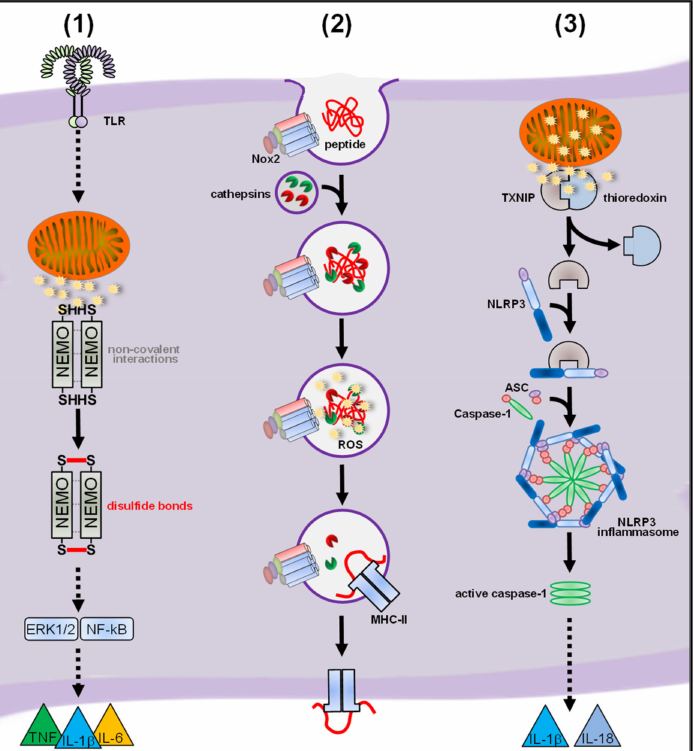
Figure 6. ( 1 ) L.m. infection induces cytosolic mtROS production by complex III of the electron trans- port chain (ETC) in a Toll-like receptor (TLR)-dependent manner. These cytosolic mtROS covalently link the I κ b kinase (IKK) complex subunit NF-kappa-B essential modulator (NEMO) via